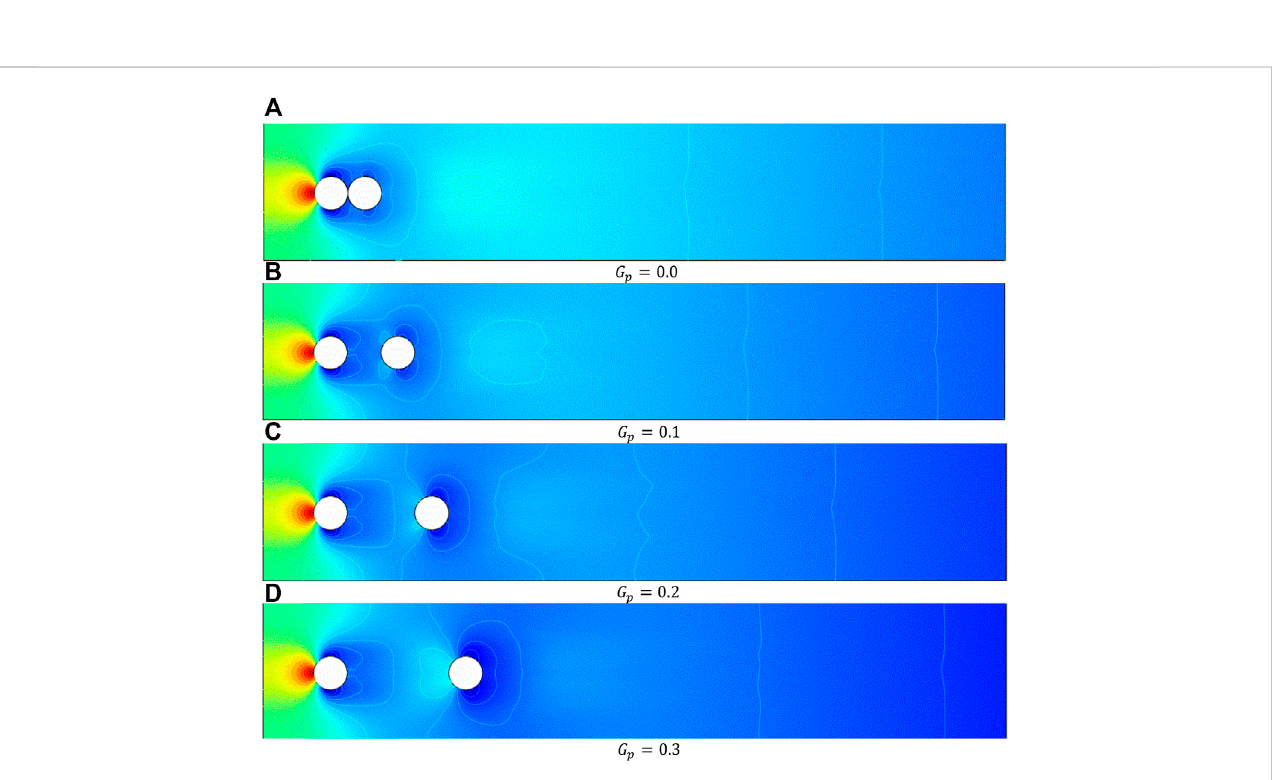
FIGURE 5 In fl uence on pressure for various gap spacings of cylinders with n (cid:2) 0 . 5 and Re (cid:2) 20.